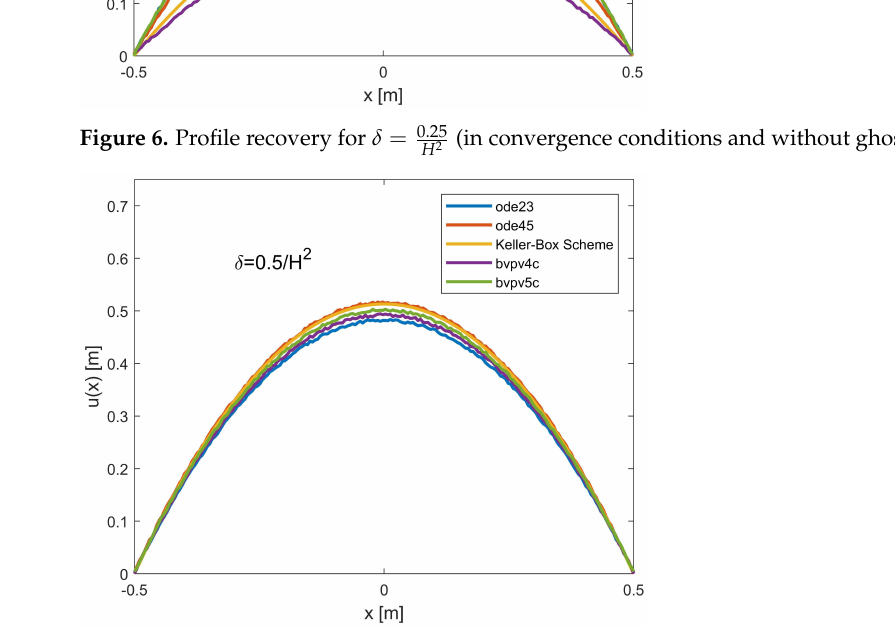
Figure 7. Profile recovery for δ = 0.5